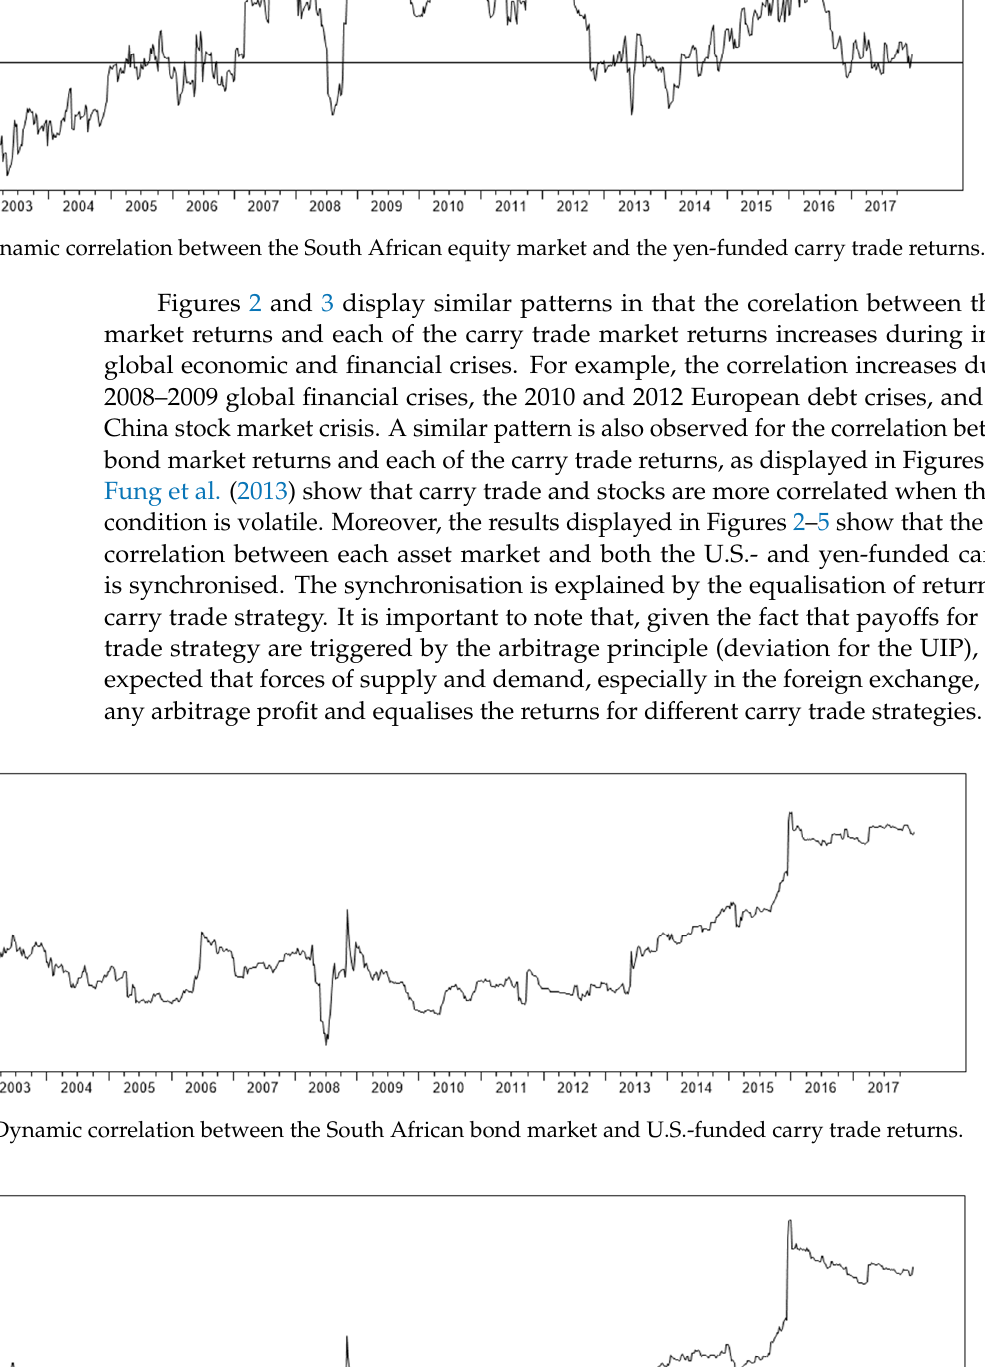
Figure 2. Dynamic correlation between the South African equity market and U.S.-funded carry trade returns.